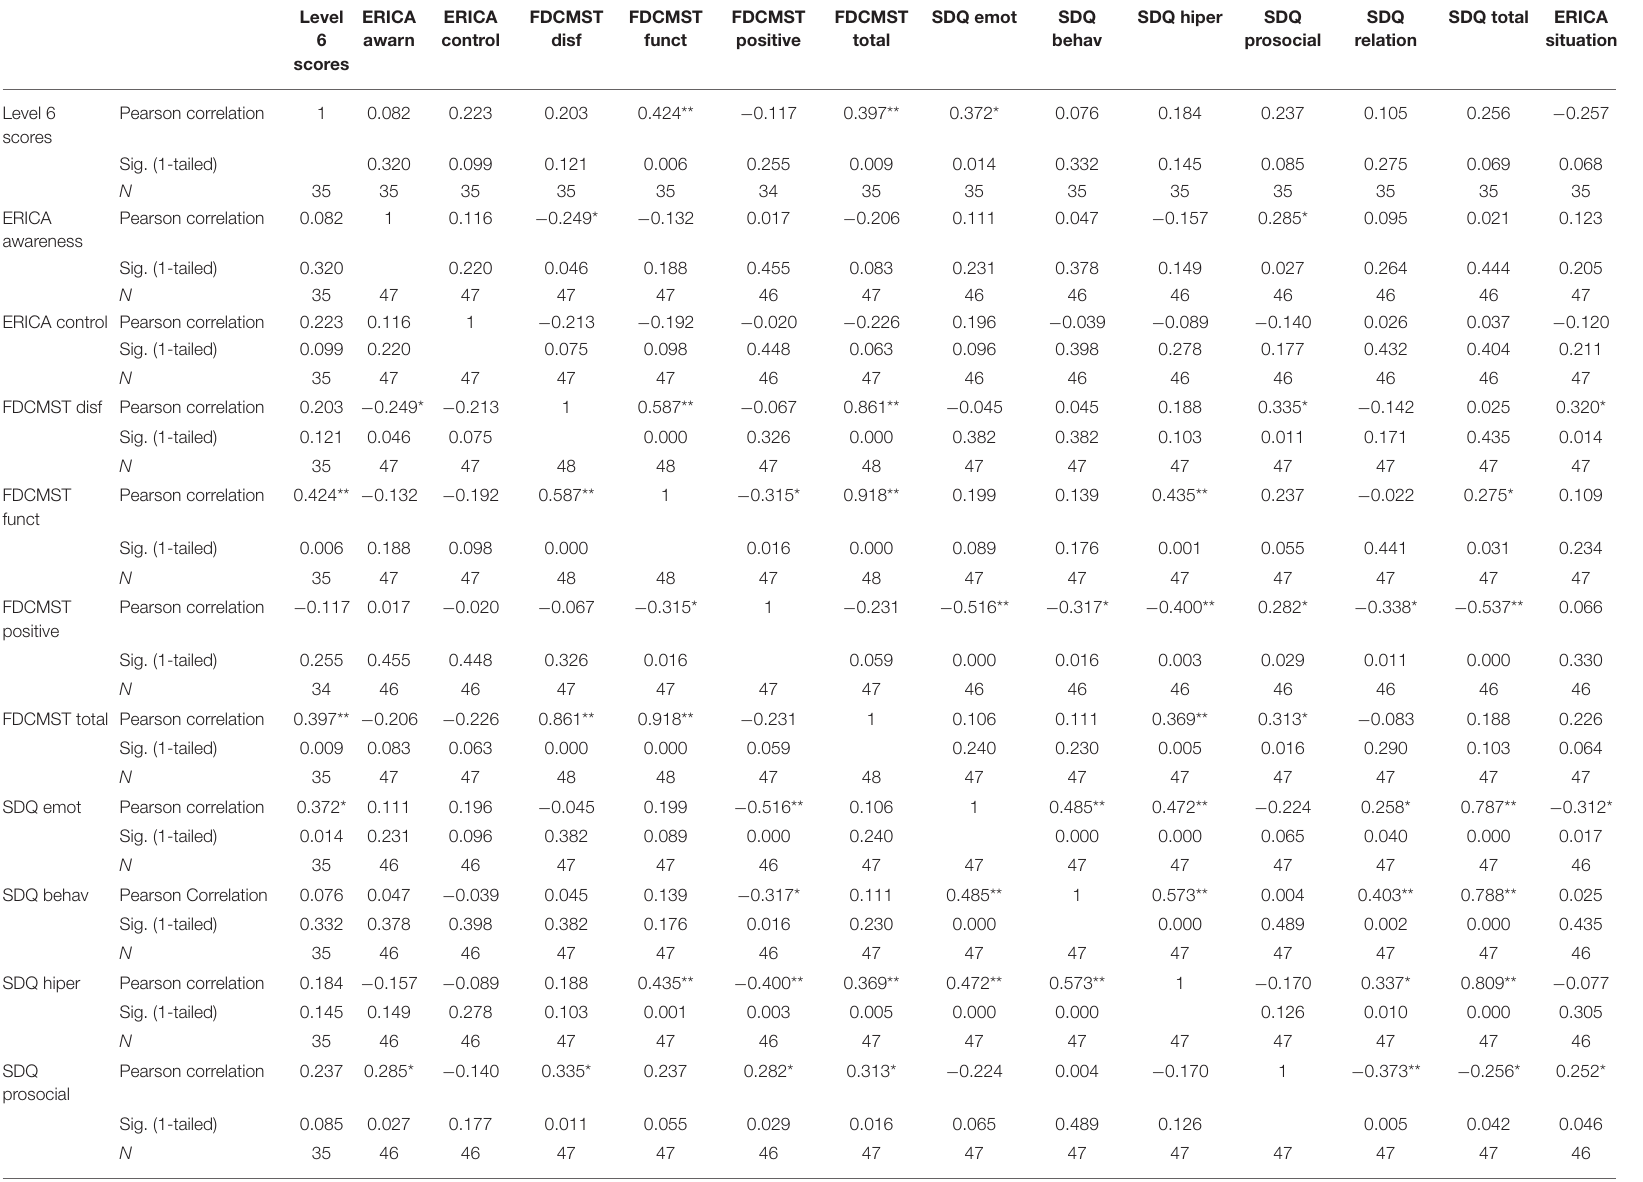
TABLE 6 | Correlation analysis for Level 6